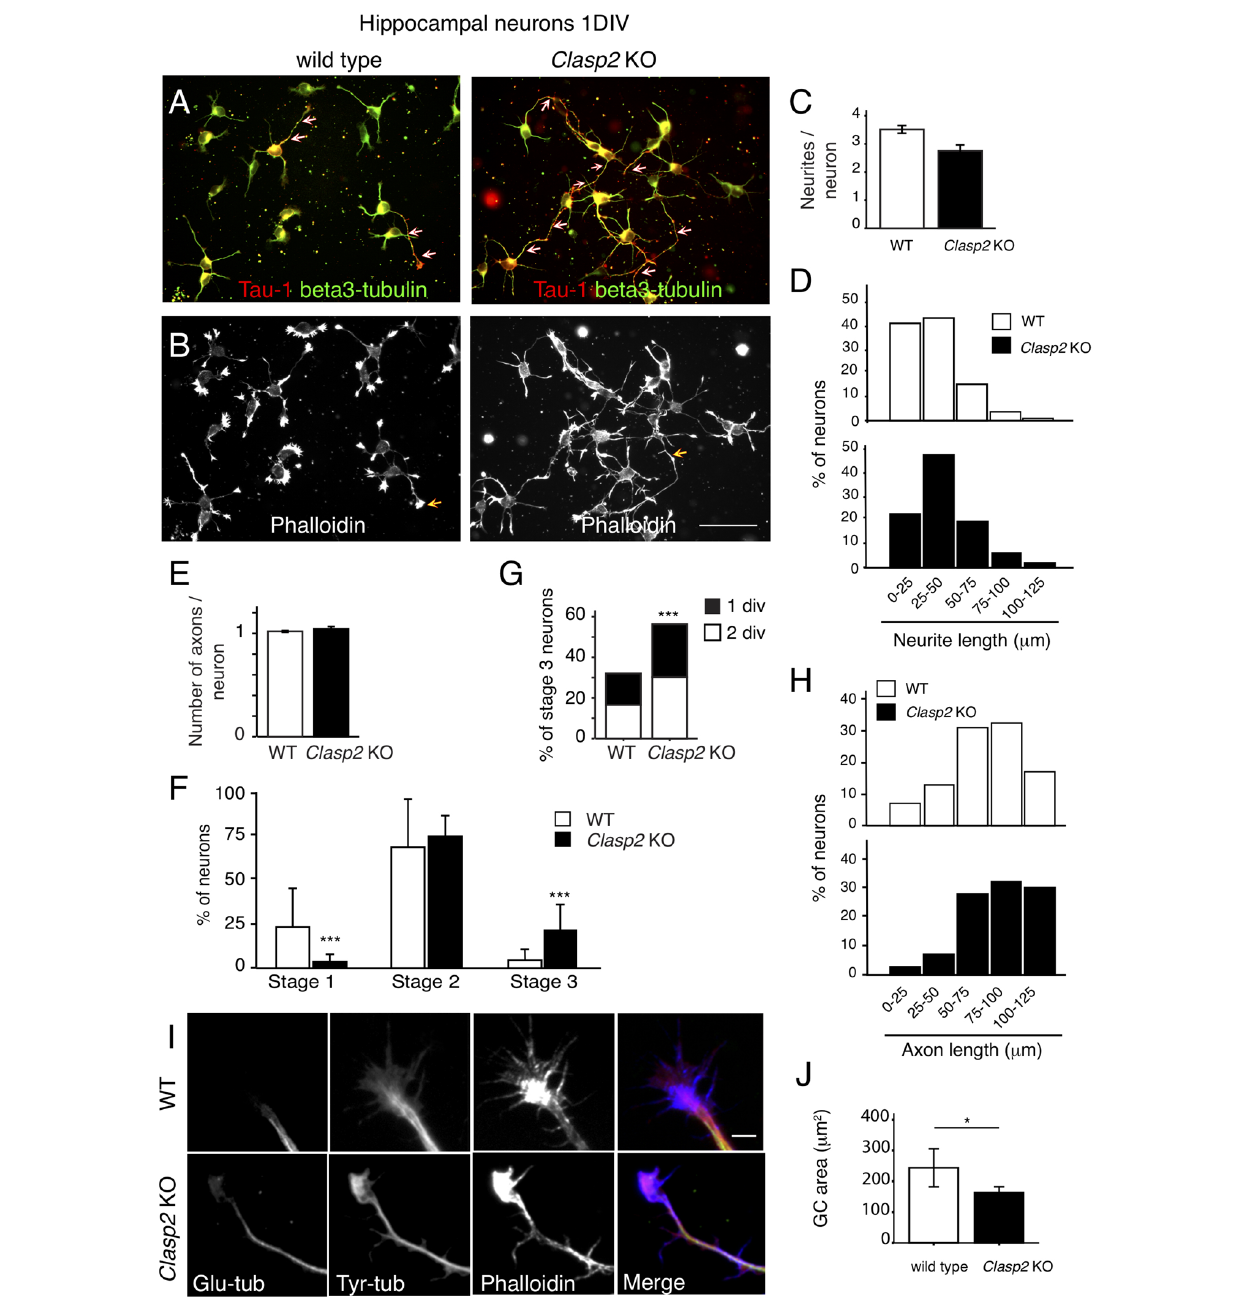
FIGURE 6 | Clasp2 knockout (KO) neurons develop longer neurites and show accelerated axon outgrowth. (A,B) WT and Clasp2 KO HNs were cultured for 1 day in vitro (1DIV), fixed and stained with antibodies against Tau1 (an axonal marker, red in merge), β III-tubulin (a neuronal marker, green in merge; A ) and phalloidin (F-actin; B ). (C) Quantification of the mean number of primary neurites/neuron in WT and Clasp2 KO neurons. No differences were found. Student T -test was performed. SD is depicted. (D) Histograms showing the distribution of primary neurite length in WT and Clasp2 KO neurons. The latter present the same number of primary neurites, but these are longer. (E) Quantification of the number of axons/neuron reveals no differences between WT and Clasp2 KO neurons. (F–H) Clasp2 KO neurons develop premature and longer axons. In (F) the percentage of neurons in stage 1, 2 or 3 (at 1DIV) was quantified and represented in histograms. In (G) , the percentage of stage 3 neurons was quantified in 1 and 2DIV WT vs. Clasp2 KO neurons. In (H) the histograms represent the distribution of axon lengths of WT and Clasp2 KO neurons. (I,J) Growth cone morphology in the absence of CLASP2. The actin and MT cytoskeleton were visualized in 2DIV WT and Clasp2 KO neurons using anti- α -detyrosinated-tubulin (Glu-tub, green in merge) and anti- α -tyrosinated-tubulin (Tyr-tub, red in merge) antibodies, in combination with phalloidin (F-actin, blue in merge). Scale bar = 10 µ m. In (J) a quantification of growth cone area is shown using phalloidin staining. WT neurons have wider growth cones with more polymerized actin than Clasp2 KO neurons. Student T -test was performed. SD is depicted in bar graph.